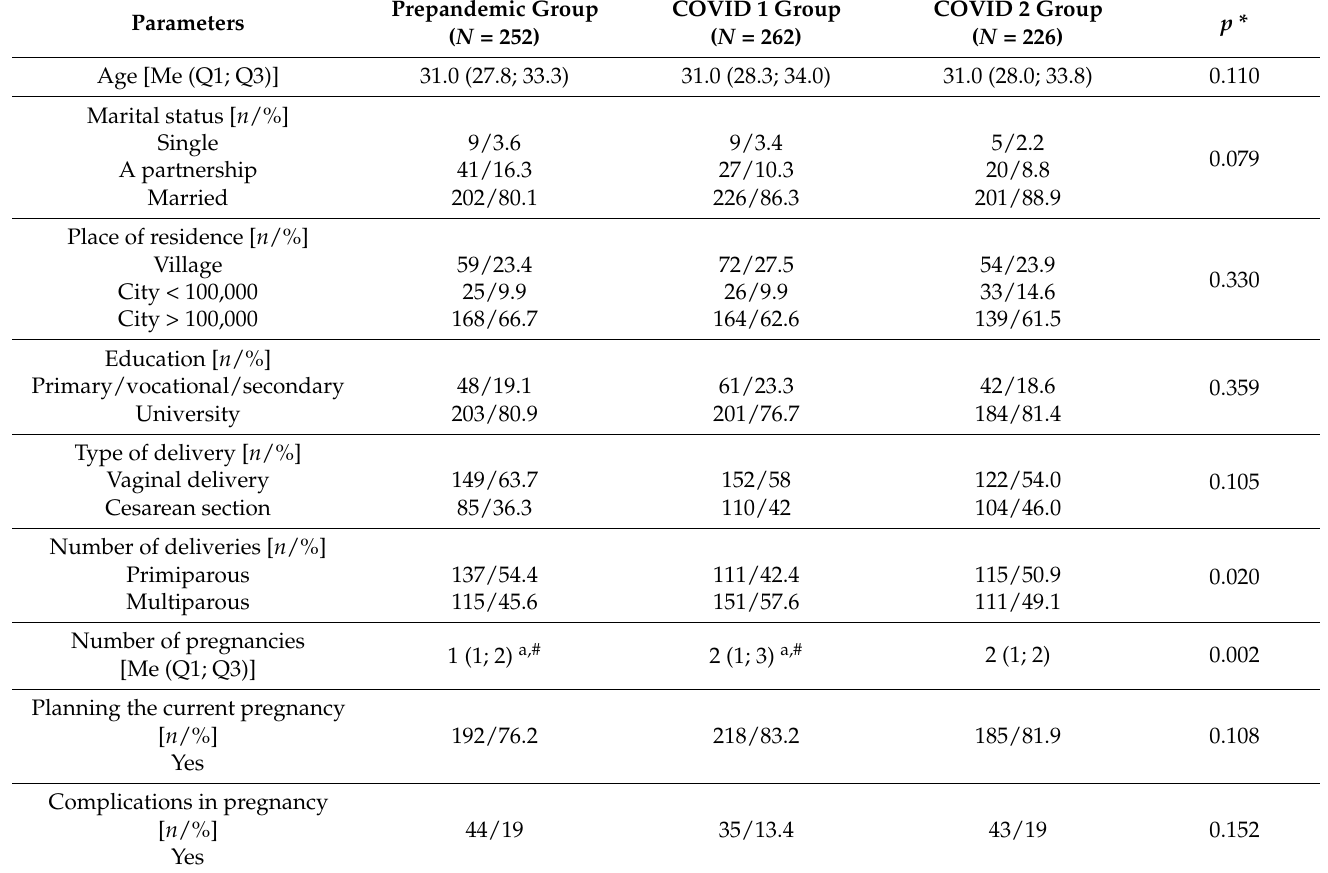
Table 1. Characteristics of the studied